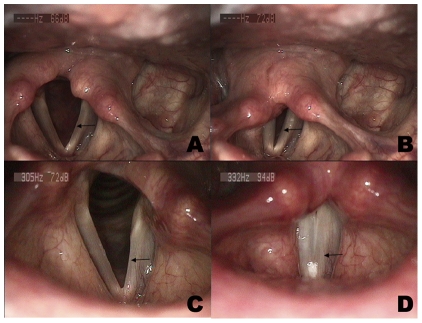
Videostoboscopic findings of a representative unilateral vocal fold paralysis (left).Preoperatively, the edge of the paralyzed vocal fold (arrow) appeared mildly bowed and vocal fold position was intermediate during inspiration (A), and a fully incompletely glottic closure presented during phonation (B). Postoperatively, the reinnervated left vocal fold (arrow) was nearly at the midline and appeared straight during inspiration (C). The bulk of left vocal fold (arrow) appeared the same as the right side postoperatively, and the glottic gap completely disappeared during phonation (D).